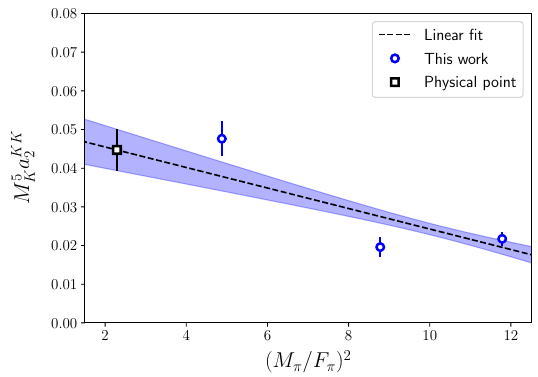
Figure 12. Results for M 5